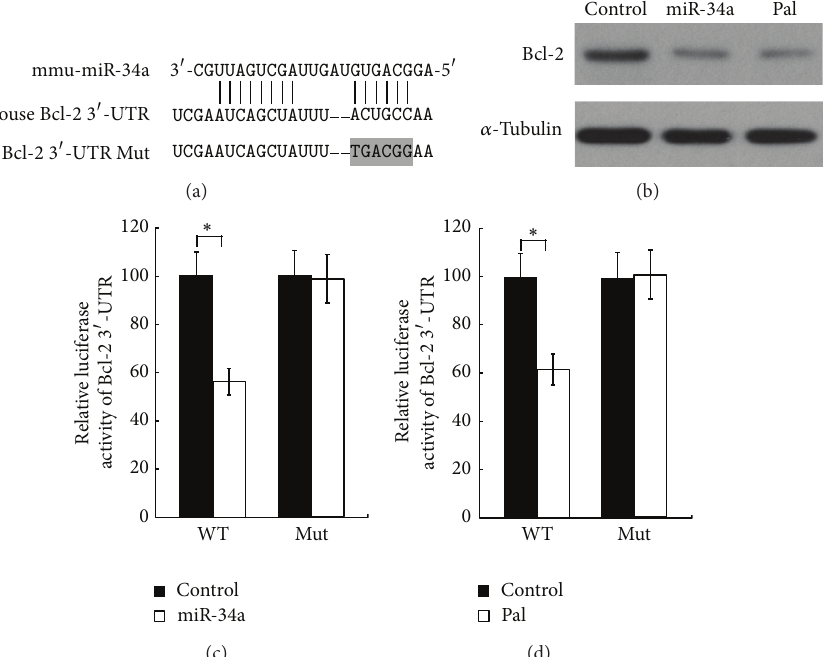
Figure 2: MiR-34a directly targets Bcl-2. (a) miR-34a binding site in the 3 󸀠 -UTR and mutated site in 3 󸀠 -UTR of Bcl-2 in the luciferase reporter. (b)EctopicexpressionofmiR-34aorpalmitatetreatmentsignificantlysuppressedtheproteinlevelofBcl-2inMin6cells.(c)miR-34ainhibited the Bcl-2 expression by interacting with the 3 󸀠 -UTR of Bcl-2. Min6 cells were cotransfected with the luciferase reporter vector containing wild-type or mutated 3 󸀠 -UTR and miR-34a mimic or control oligonucleotides. (d) The effects of palmitate treatment on the luciferase activity of reporter vector containing wild-type or mutated 3 󸀠 -UTR. For (c) and (d), data are shown as means ± SD of three independent experiments ∗ 𝑃 < 0.05